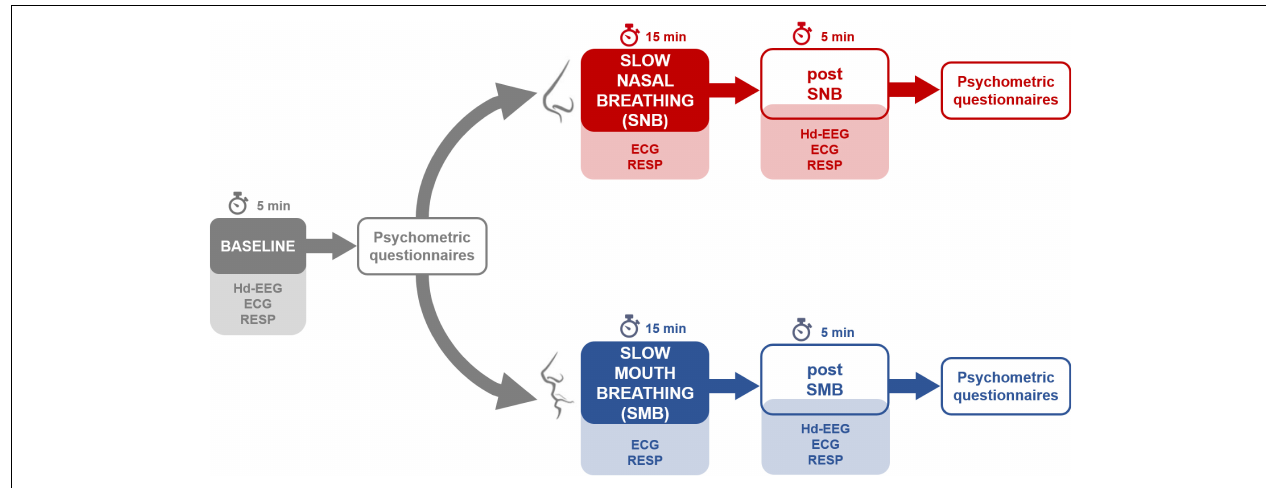
FIGURE 1 | An overview of the experimental procedures for the two sessions. Note that both sessions began with a baseline recording, followed by the administration of psychometric